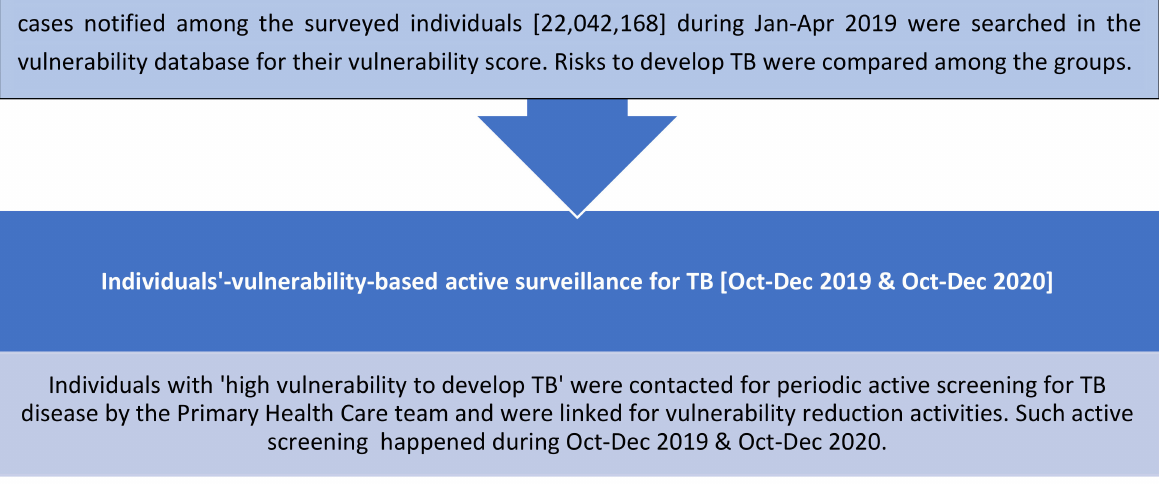
Figure 1. Flowchart representing the process for individual-vulnerability-based active surveillance of